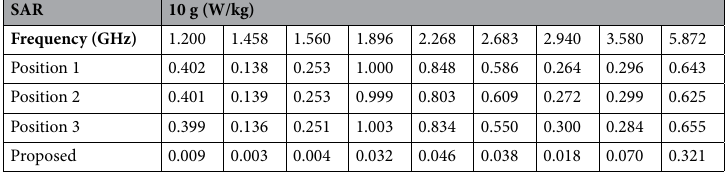
Table 8. SAR reduction values for 10 g of tissue volumes at various metamaterial positions.